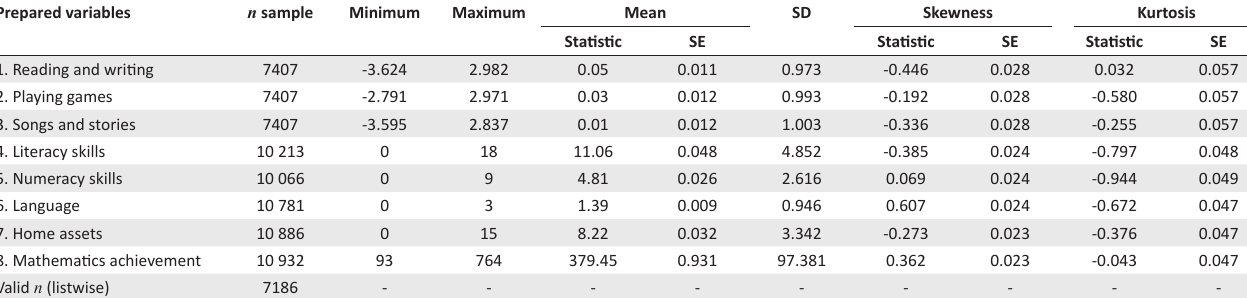
TABLE 3: Descriptive statistics of the prepared